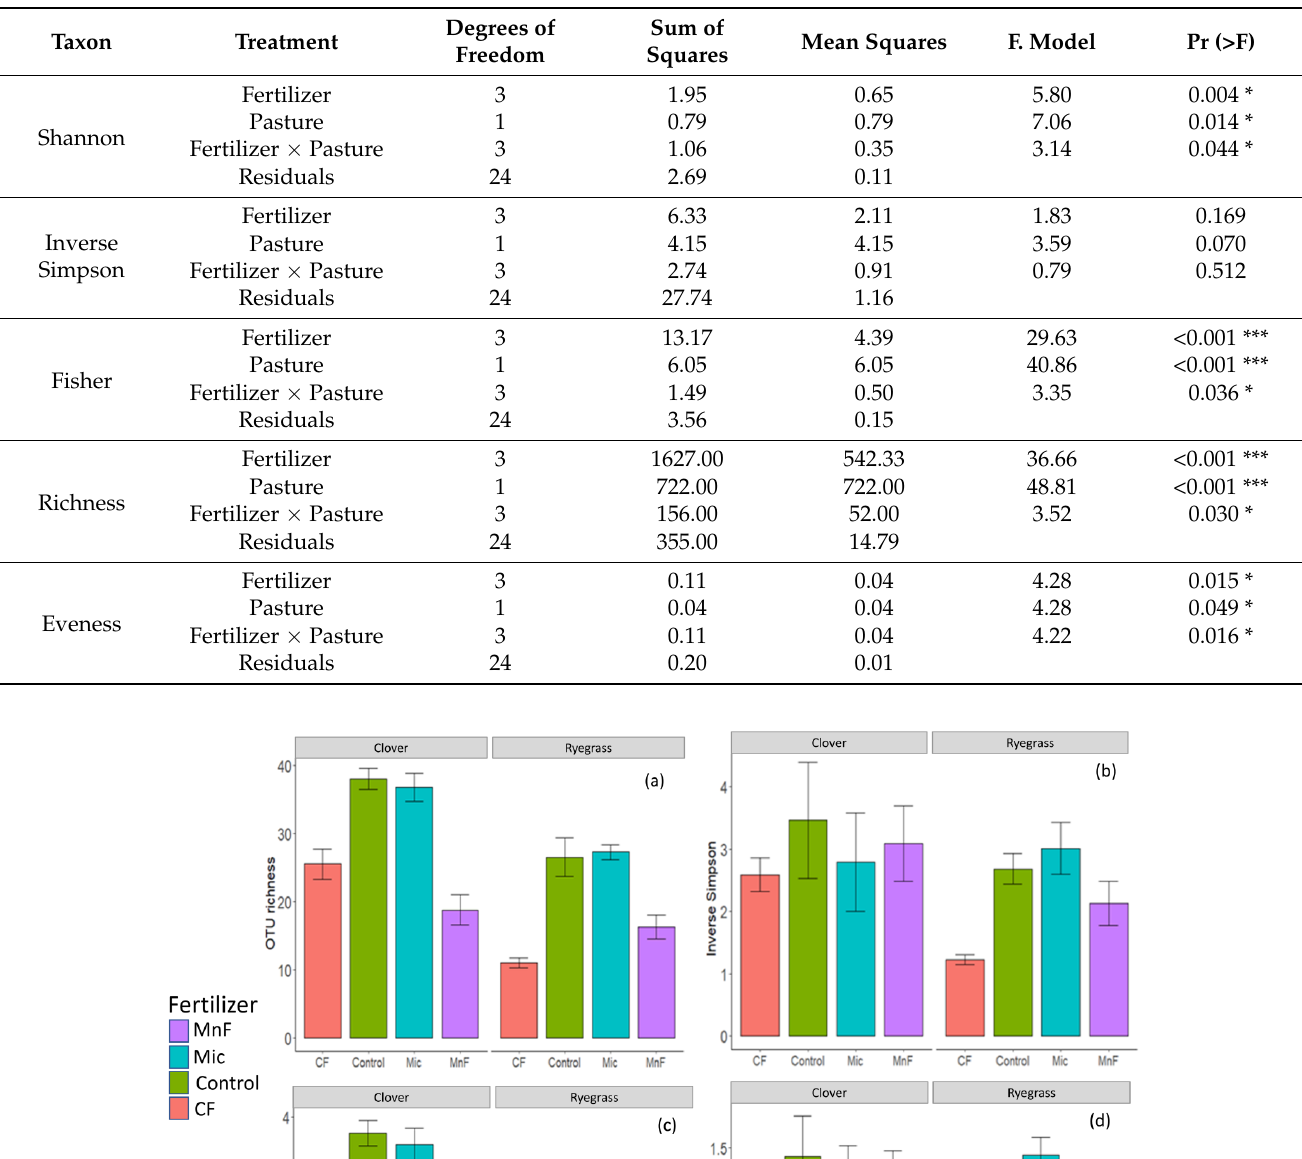
Table 5. Root AM fungi two-way ANOVA results showing p values fixed at family resolution of relative abundance. Treatments consisted of ‘Fertilizer’, and ‘Pasture’. Significant p values indicated by * and *** corresponding to p < 0.05 and < 0.001, respectively.